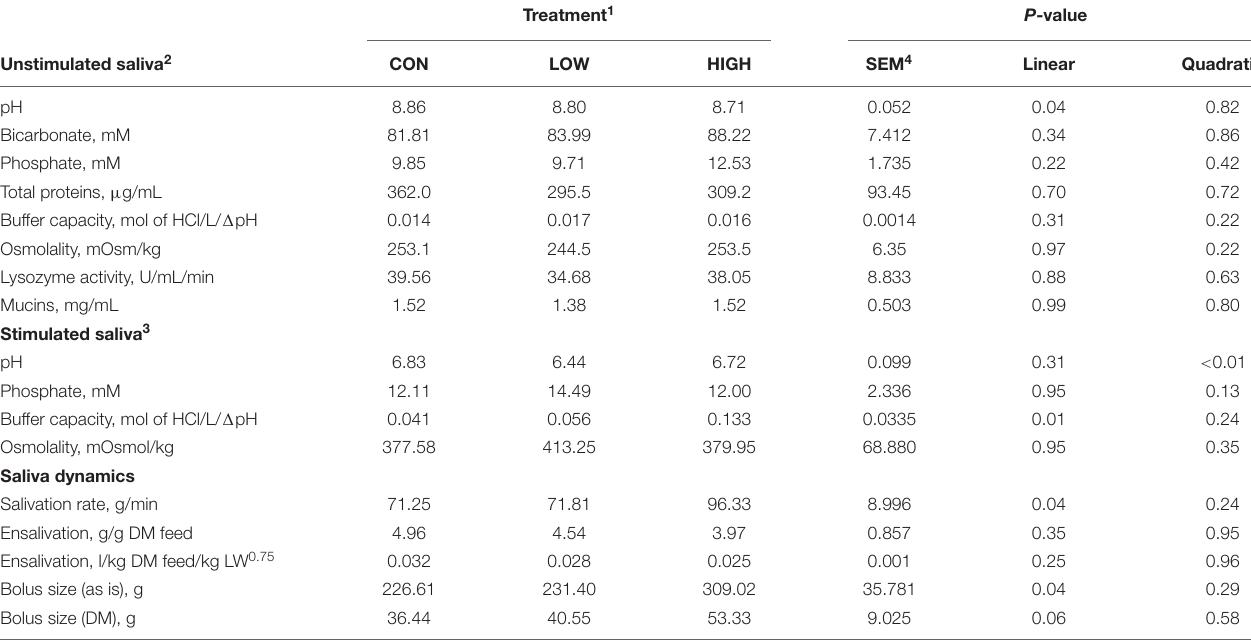
TABLE 4 | Effect of supplementation with thymol on salivary physico-chemical properties, salivation, and feed bolus dynamics of non-lactating Holstein dairy cows. Treatment 1